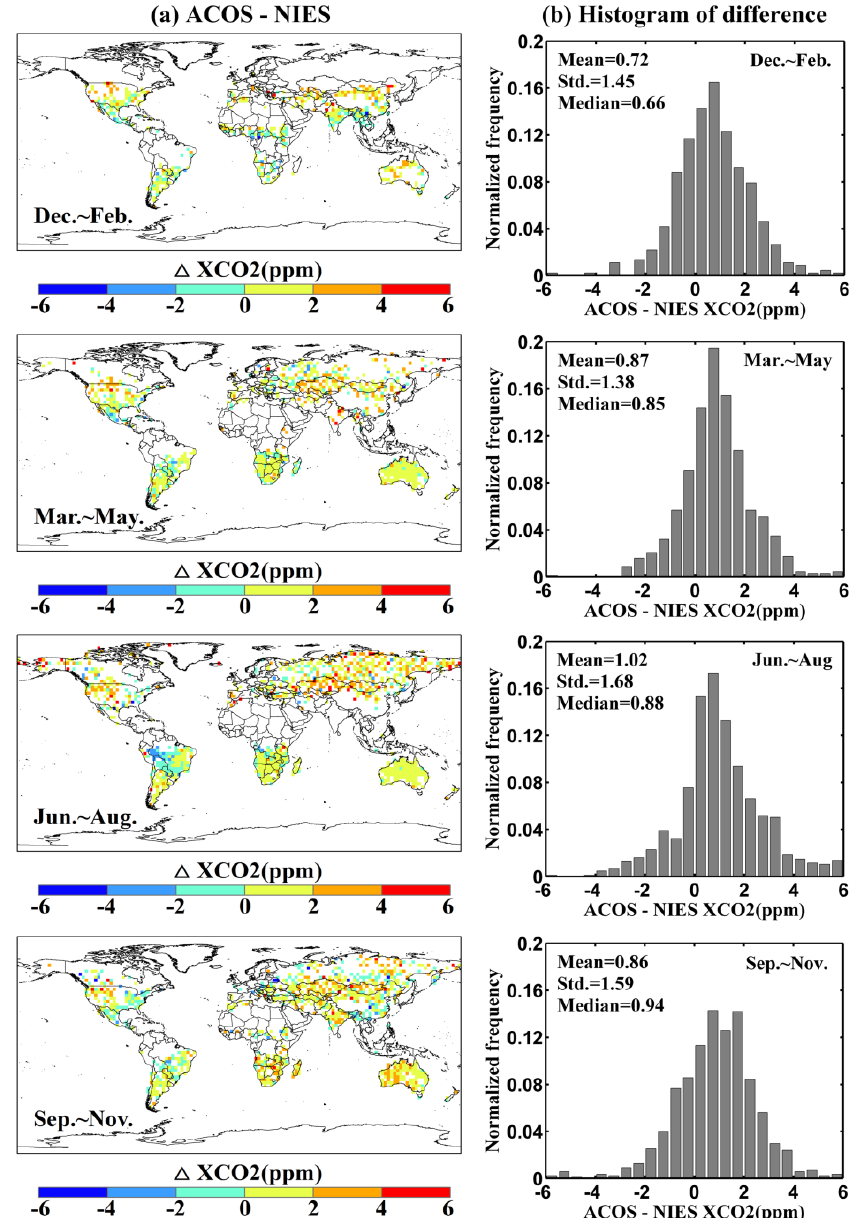
Figure 5. Seasonal difference ( a ) gridded in 2.5° × 2.5° bins between ACOS and NIES XCO 2 means and the histogram of their difference ( b ) in each season from December 2011 to November 2012.